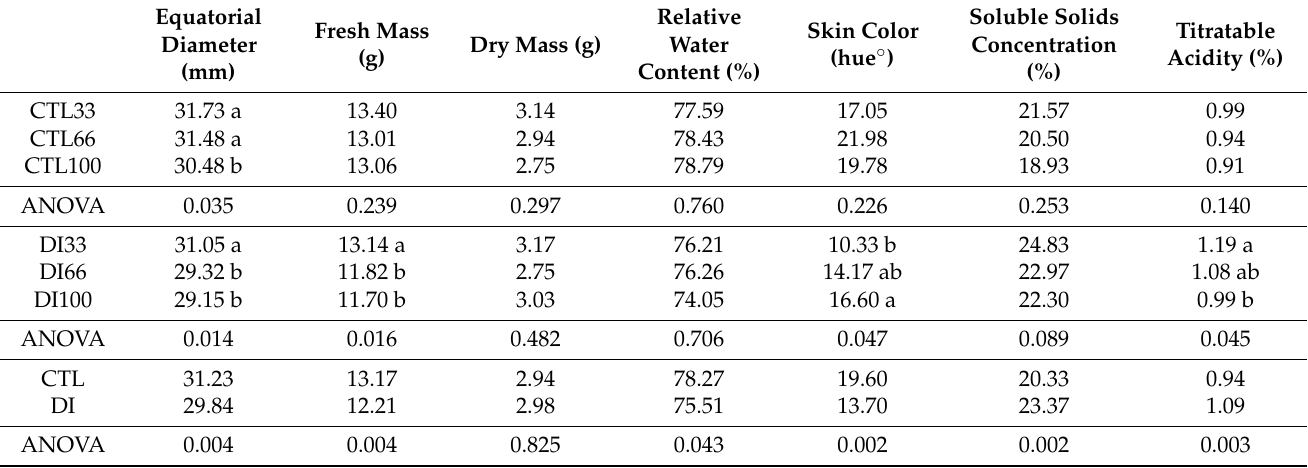
Table 2. Effect of the irrigation treatment (control (CTL) and deficit irrigation (DI)) and crop load